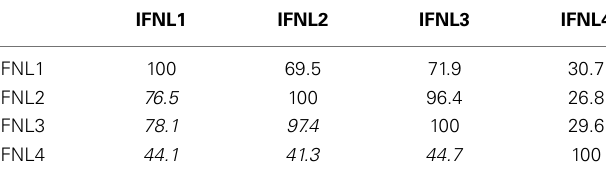
Table 1 |Amino-acid conservation table